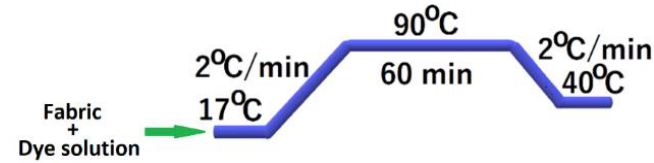
Figure 3. Wool dyeing diagram.